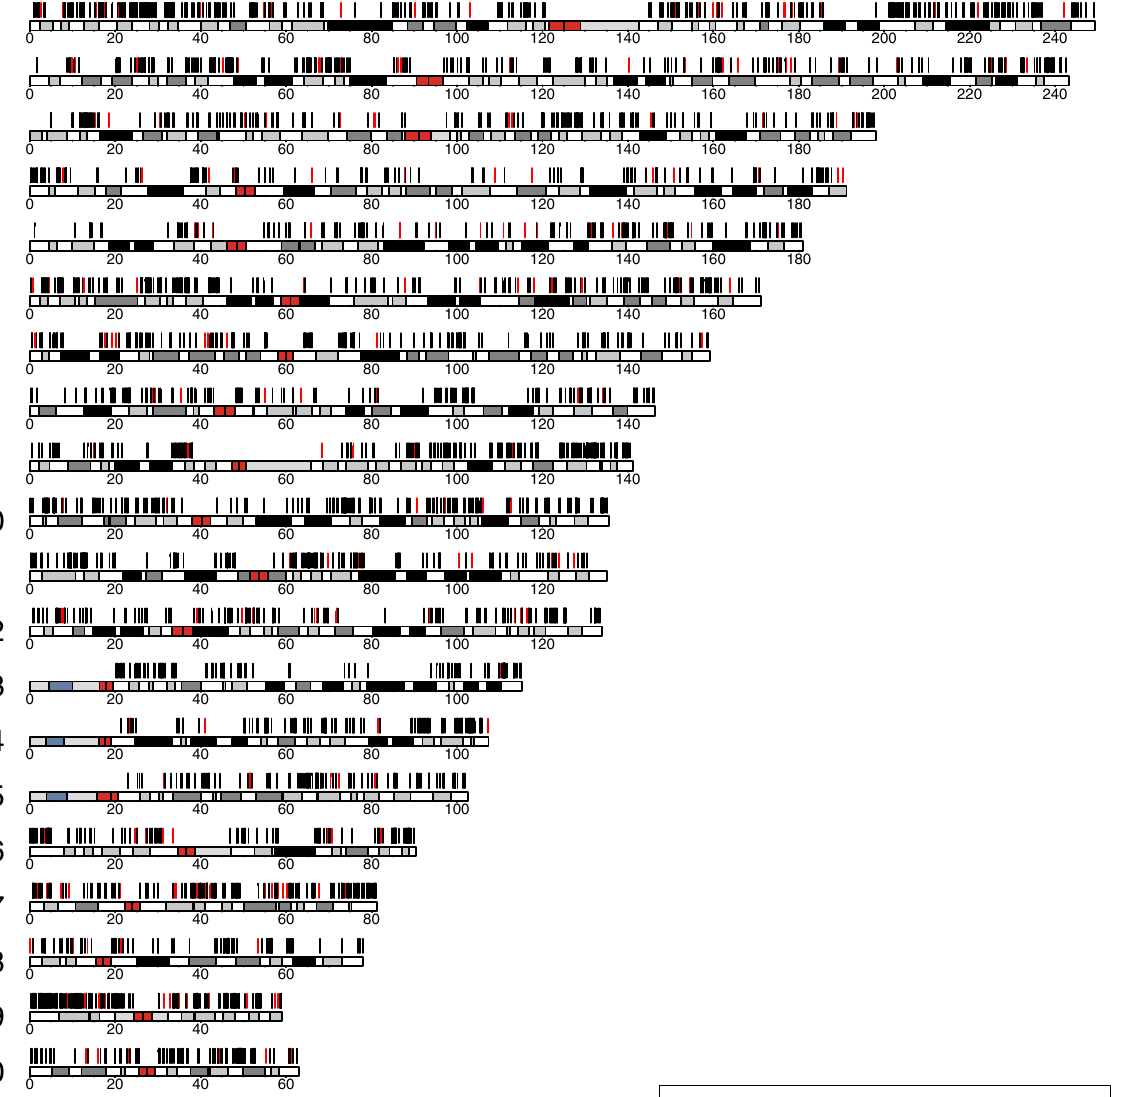
with preterm birth and gestational age (relative fold enrichment: 2.23, P < 0.0001). Thus, there is evidence to suggest that additional regulatory regions relevant to placental biology are pres- ent in the candidate set.